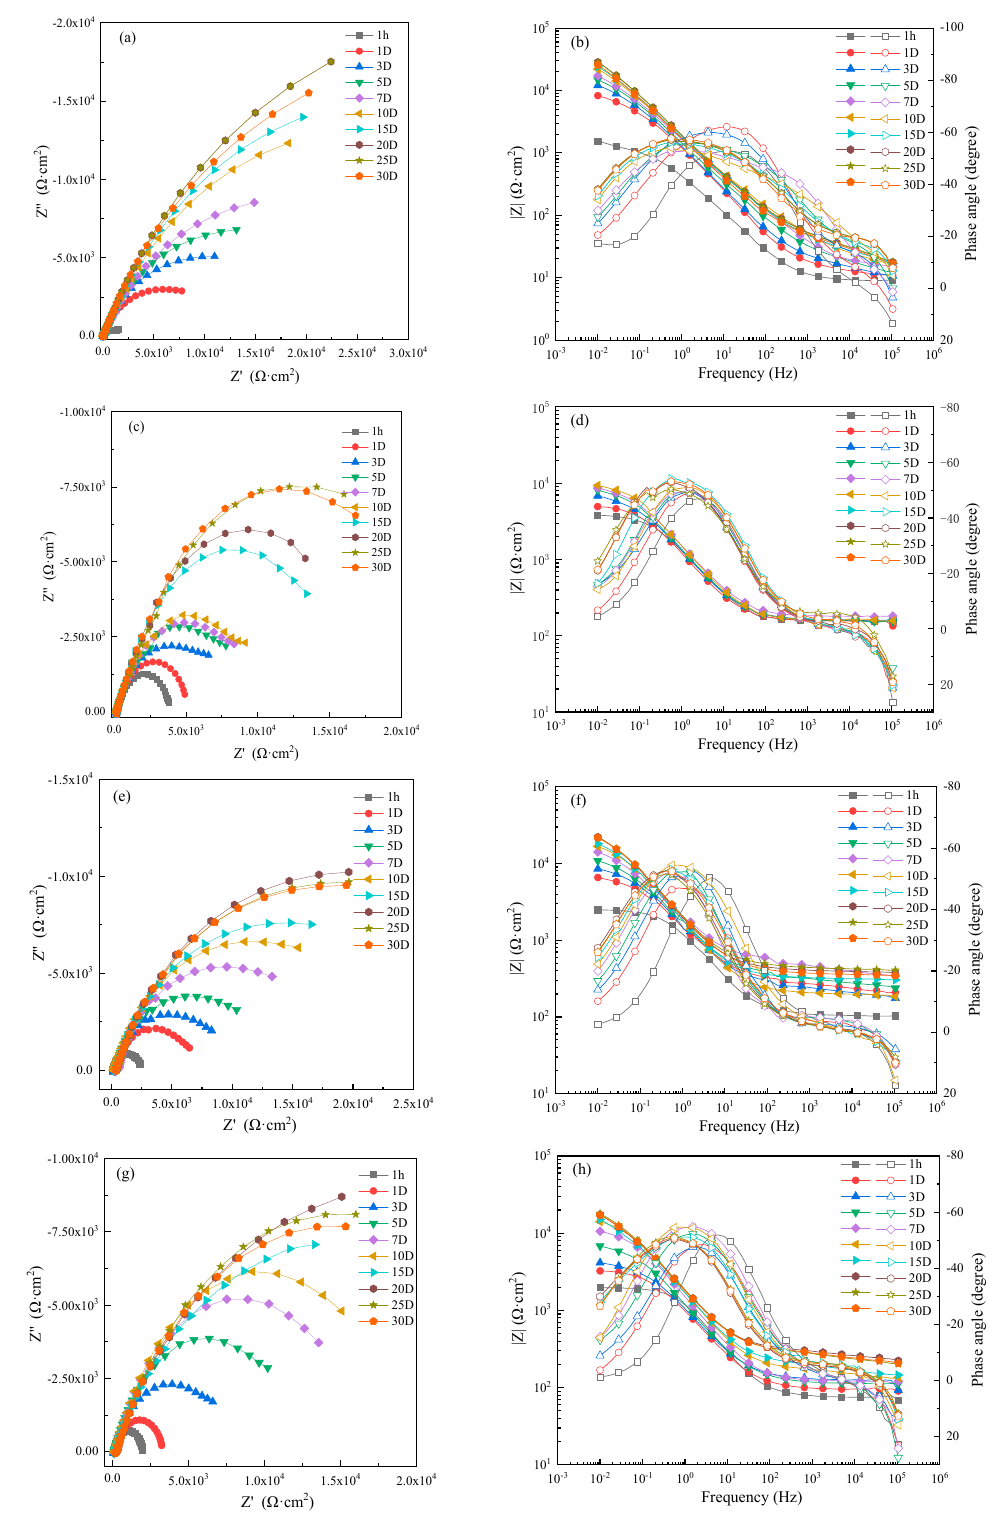
Figure 4. Electrochemical impedance spectra of MZ in seawater: ( a , c , e , g ) Nyquist diagrams and ( b , d , f , h ) Bode diagrams in static, 1 m/s, 3 m/s, 5 m/s seawater.